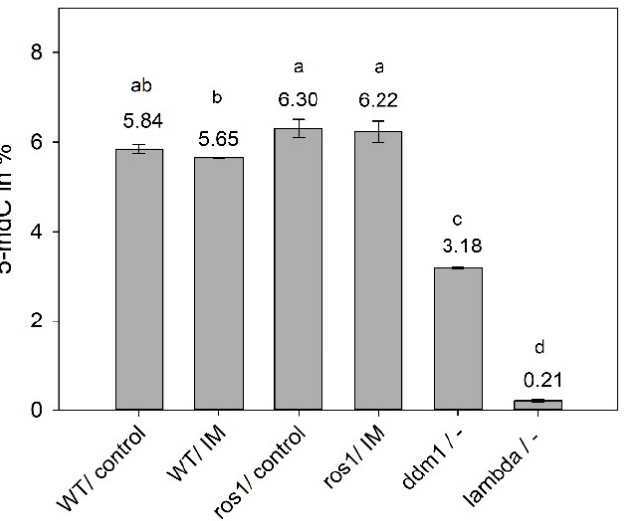
Figure 4. HPLC measurement of global 5-mdC (%) in wild type (WT) and ros1 , in the control condition and after treatment with imazethapyr (IM), 48 h after treatment. ddm1 and lambda phage DNA were used as low and high DNA methylation controls, respectively. Error bars denote standard deviations from three biological replicates. Means followed by a different letter differ significantly according to Tukey’s test ( p ≤ 0.05).